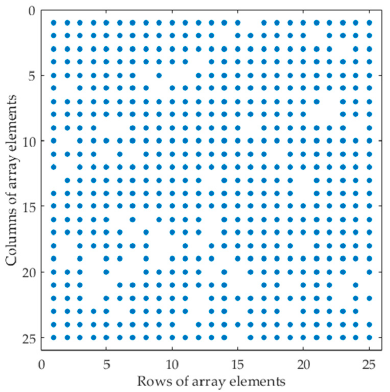
Figure 17. Random sparse array elements distribution. The range profile obtained in 3D space is shown in Figure 7.